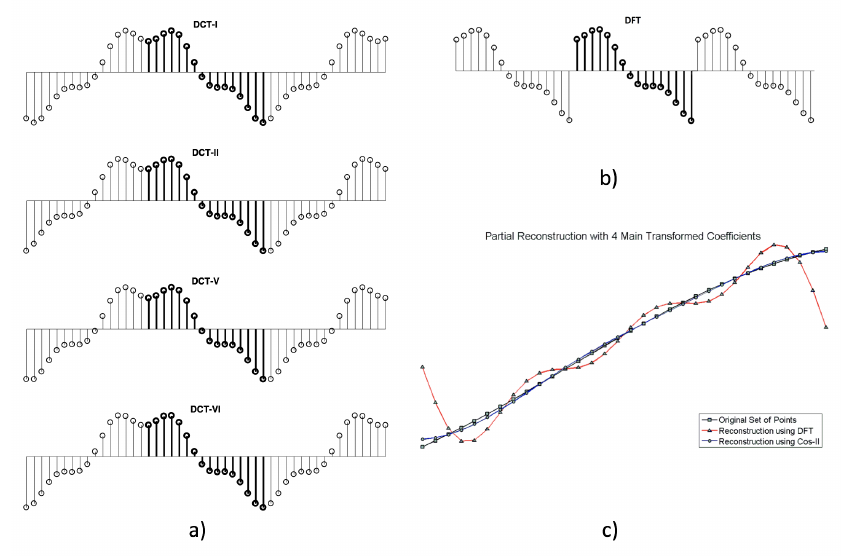
Figure 3. ( a ) Implicit extensions outside the main range for discrete cosine transform (DCT) formulations -I, -II, -V and -VI. The main sequence is in bold. ( b ) Discrete Fourier transform (DFT) implicit extensions for the same sequence. ( c ) Reconstruction of a set of 32 original points (squares) using four real DCT-II coefficients c 0 , c 1 , c 2 , c 3 (circles) and seven complex DFT coefficients f 0 , f 1 , f 2 , f 3 and f 29 , f 30 , f 31 (triangles). Note that f 29 , f 30 , f 31 are the complex conjugates of f 3 , f 2 , f 1 ,